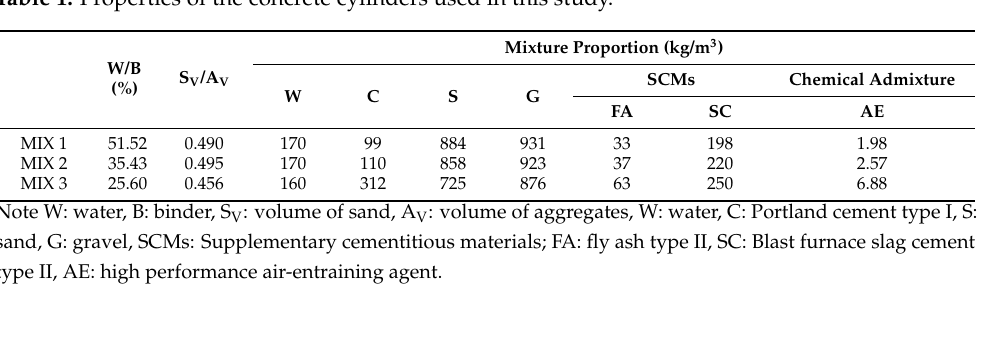
Table 1. Properties of the concrete cylinders used in this